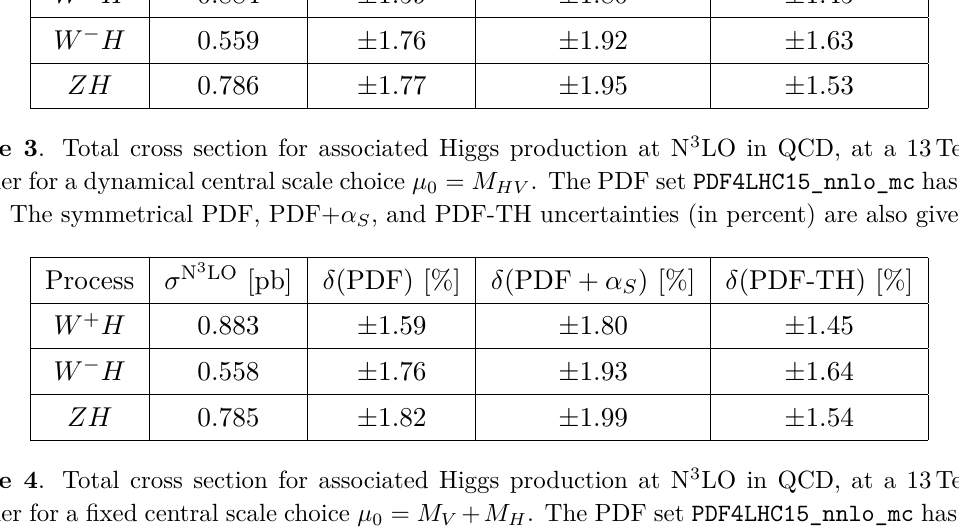
= M + M . The PDF set PDF4LHC15_nnlo_mc has been 0 V H , and PDF-TH uncertainties (in percent) are also S